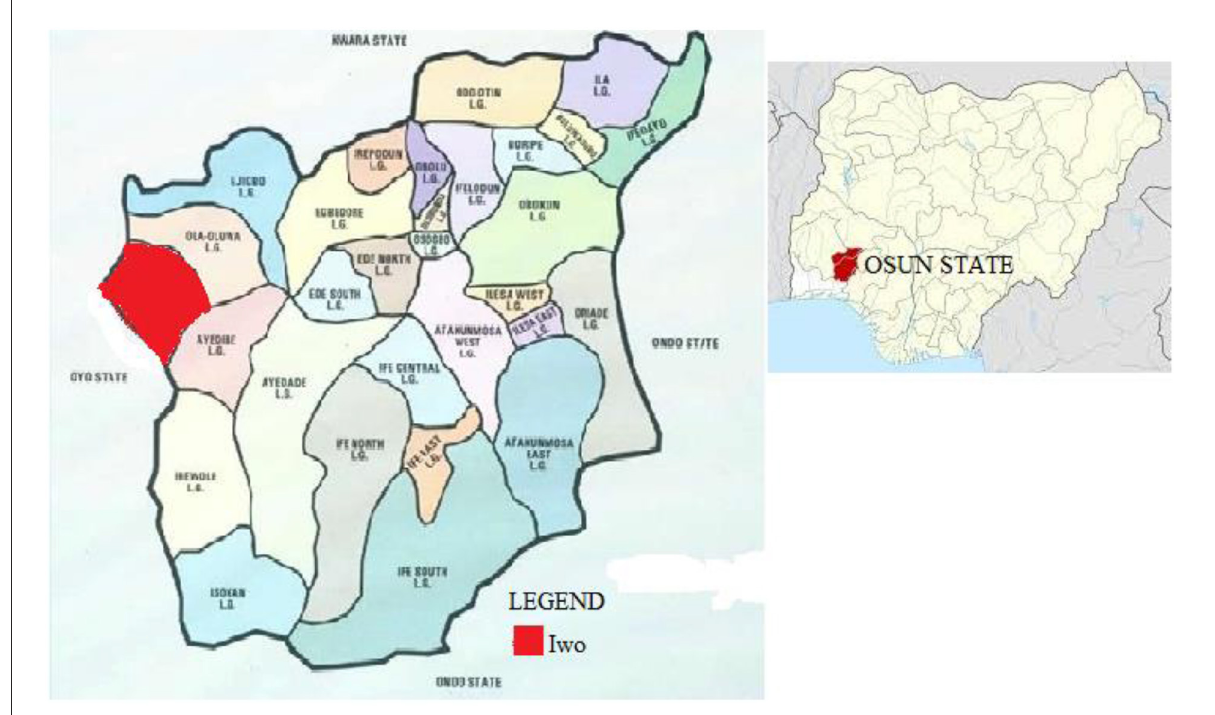
FIGURE1 Map of Osun State showing the location of Iwo (Inset: Map of Nigeria showing the location of Osun